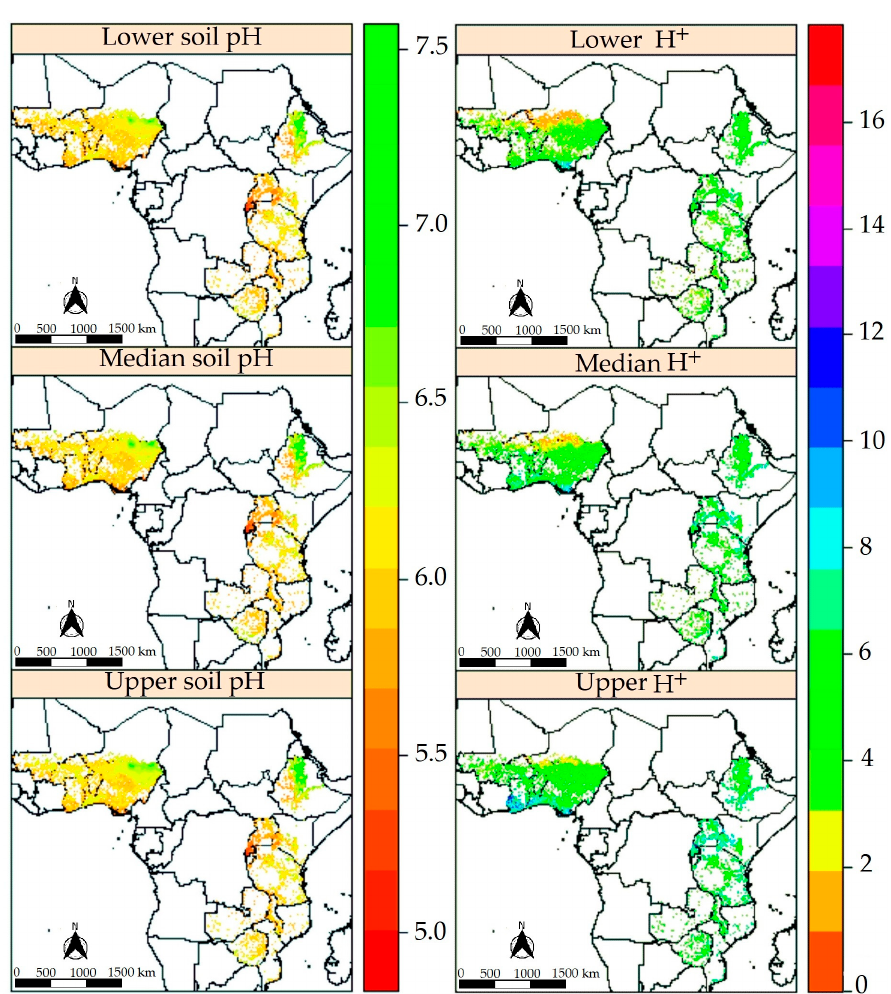
Figure 5. Spatial prediction of soil pH and soil acidification: upper, median, and upper soil pH ( left side) and lower, median, and upper soil acidification (keq H + ha − 1 yr − 1 ) ( right side).